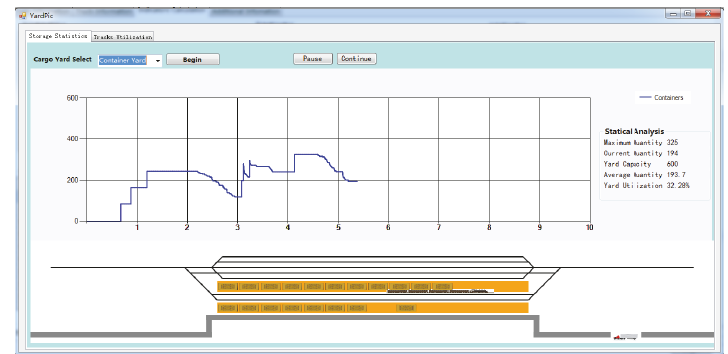
Figure 10: Snapshot of the platform interface during simulation.